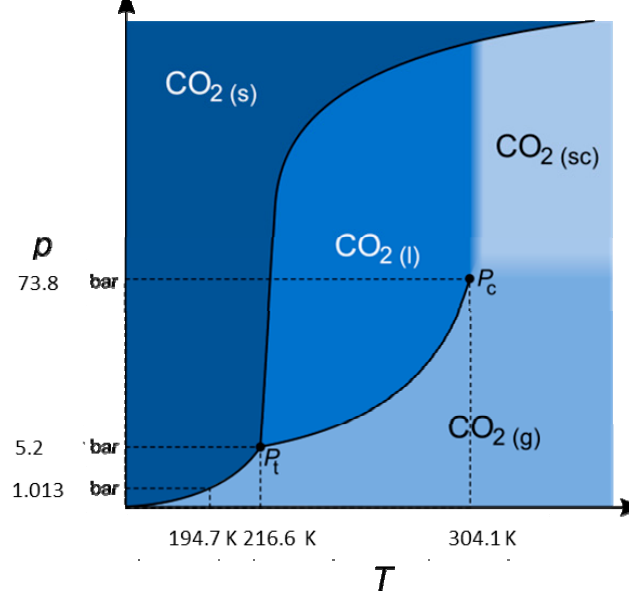
Figure 5. Pressure and temperature phase diagram of CO 2 [158,159]. K: Kelvin, p: pressure, T: temperature, sc: supercritical, l: liquid, g: gaseous, s: solid.